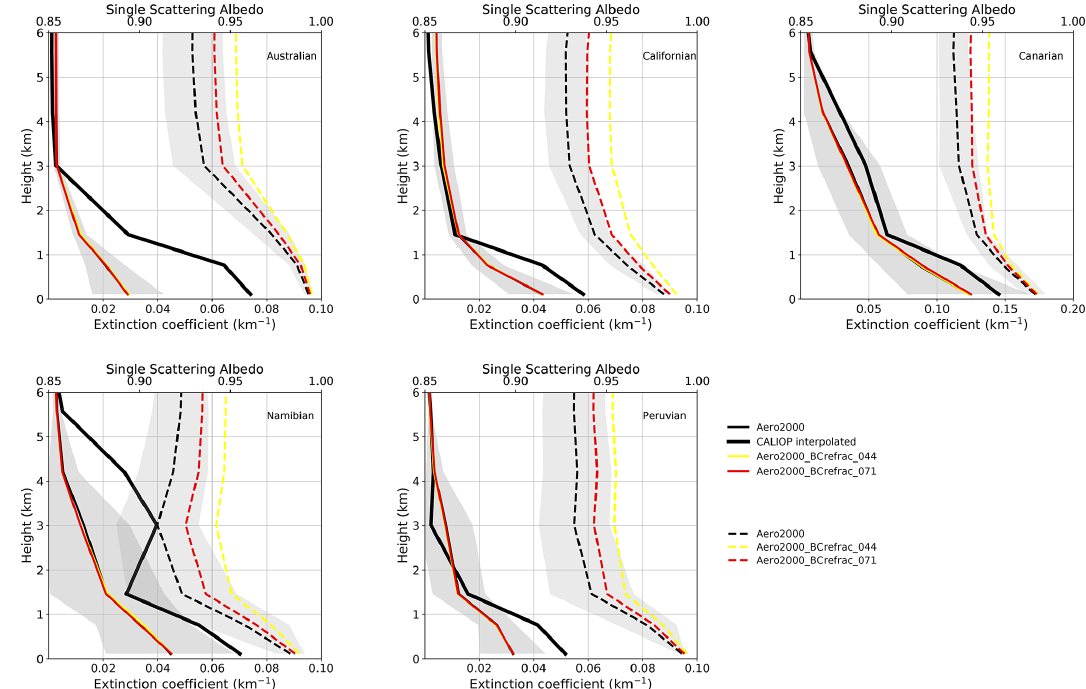
Figure 10. Vertical distribution of the aerosol extinction coefficient (km − 1 ; solid line) and single-scattering albedo (SSA; dashed line) for the Australian, Californian, Canarian, Namibian, and Peruvian regions for the model control simulation and sensitivity experiments in the category aerosol optical properties. The SD of the model control simulation is indicated as a grey shaded